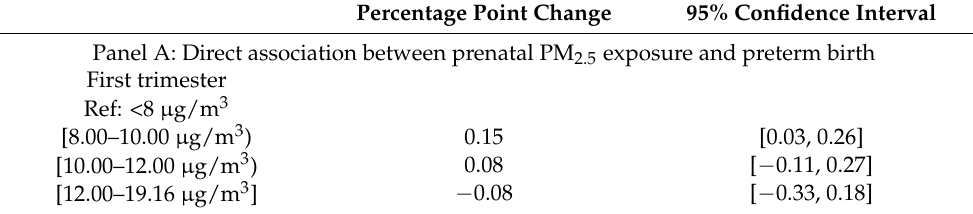
Table A7. Estimates of the association between prenatal PM 2.5 exposure, post-birth PM2.5 exposure (defined over 2 months), preterm birth, low birth weight, and infant mortality from the Structural Equation